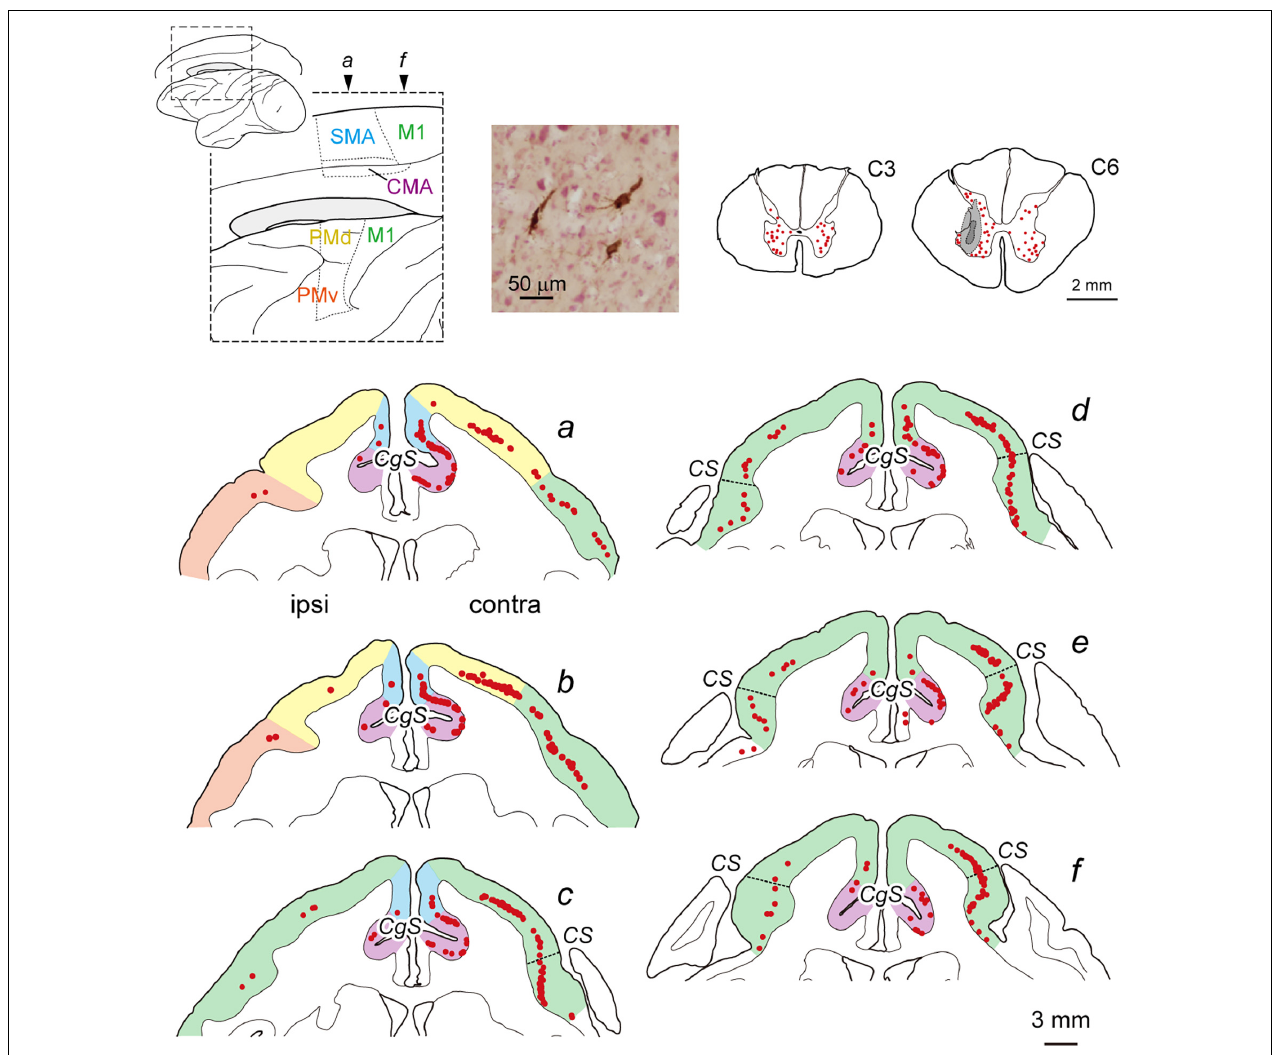
FIGURE 1 | Distribution of cortical neurons projecting monosynaptically to the forelimb segments (C6–T1) of the spinal cord (monoCSP) in intact monkey (Experiment A). Distribution of retrograde labeling in the motor-related areas of the frontal lobe in an intact monkey (monkey A1) 2 days after rabies injections into the forelimb segments ( a – f ). The approximate anteroposterior levels of the six frontal sections and the parcellation of the motor-related areas (dotted lines) are indicated in the lateral and medial views of the brain on the top left. In each section, the motor-related areas are also divided by colors. Neuronal labeling in the C3 segment and the site of rabies injection in the C6 segment are depicted in representative transverse sections (top right). The first-order neuron labeling is seen extensively over the motor-related areas contralateral to the rabies injections and is confined to layer 5 across the areas. A photomicrograph on the top shows labeled neurons in M1 layer 5. Weak labeling is also observed ipsilaterally in the motor-related areas. Each red dot in the sections corresponds to one labeled neuron. Dashed lines in the frontal sections c – f denote the border between “old” and “new” M1. CMA, cingulate motor areas; CgS, cingulate sulcus; contra, contralateral to rabies injections; CS, central sulcus; ipsi, ipsilateral to rabies injections; M1, primary motor cortex; PMd, dorsal premotor cortex; PMv, ventral premotor cortex; SMA, supplementary motor